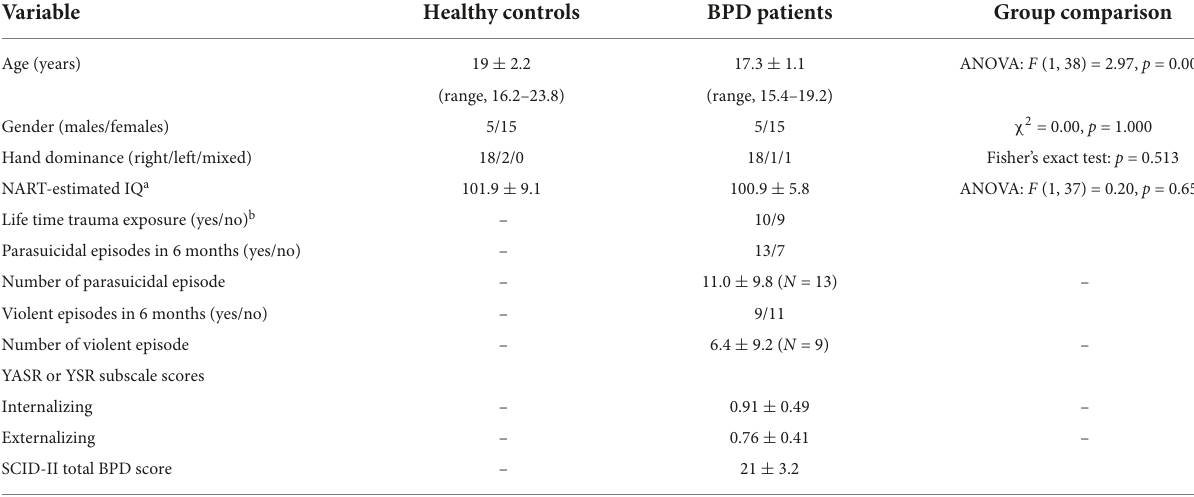
TABLE 1 Demographic and clinical characteristics of the study participants. Variable Healthy